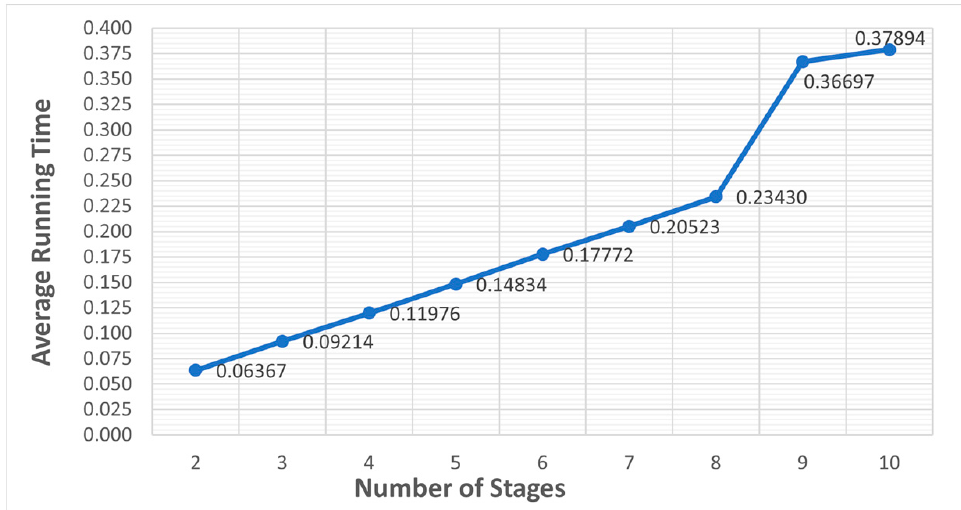
Figure 6. Effect of increasing number of progressive stages in rain streak removal network on running time (in seconds).